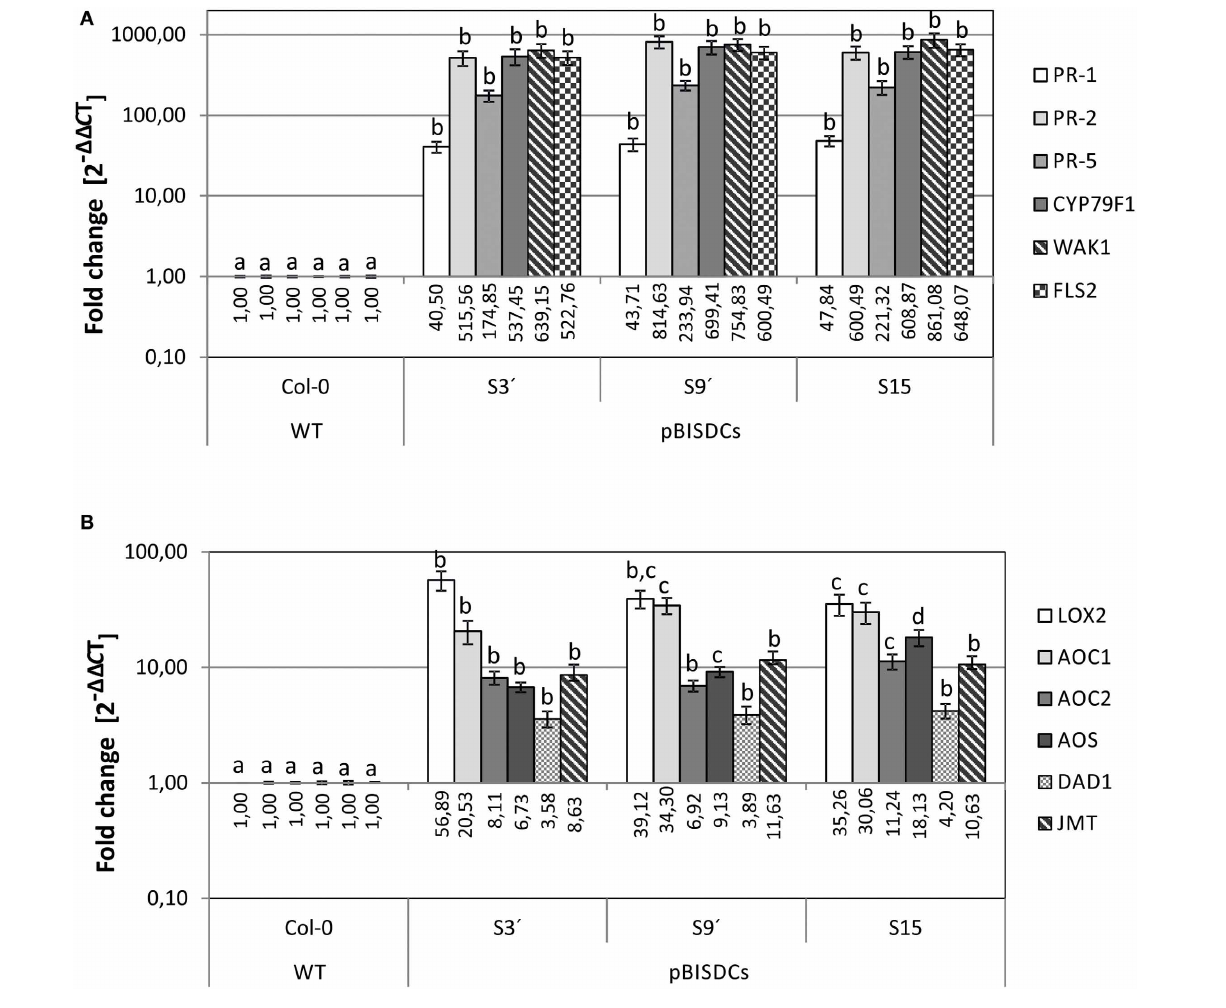
FIGURE 1 | qRT-PCR analysis of biotic stress-related genes in leaves of 4-week old A. thaliana WT and pBISDCs transgenic lines overexpressing SAMDC1 (S3 (cid:2) , S9, and S15). Expression levels were determined for a set of biotic stress defense-related